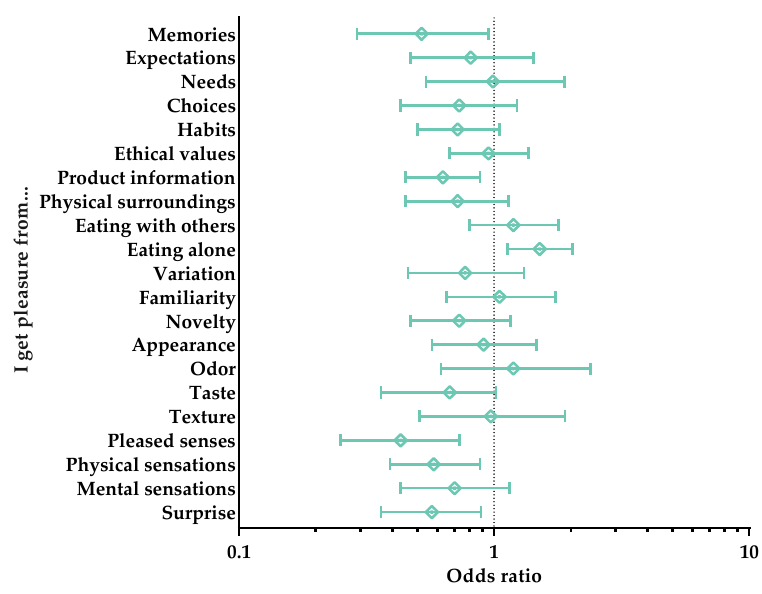
Figure 6. Intermediate anhedonia group. Overview of results of multivariate regression analyses for the subjective perception of the 21 different pleasure aspects of the Food Pleasure Scale. Results are shown as odds ratios, including interquartile ranges. An odds ratio > 1 indicates an increased likelihood of choice, whereas odds ratio < 1 indicates a decreased likelihood of choice.